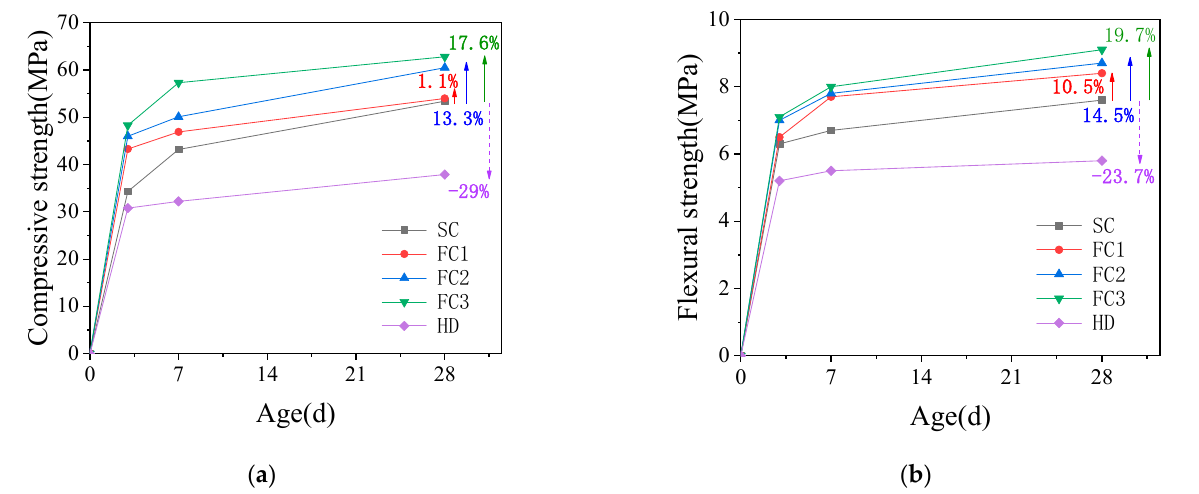
Figure 4. Strength of cement-fly ash mortar (FA45-M), ( a ) Compressive strength and ( b ) Flexural strength.